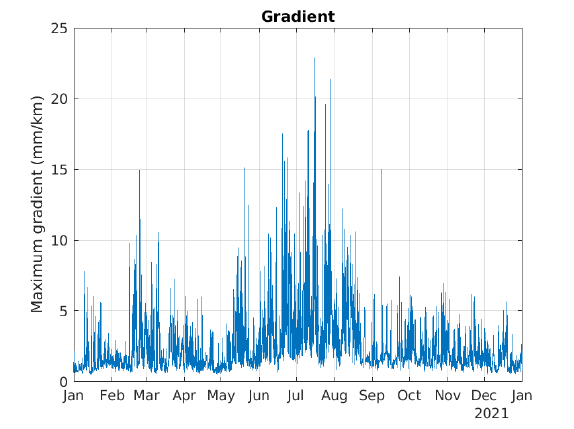
Figure 5. Maximum gradient as a function of time.